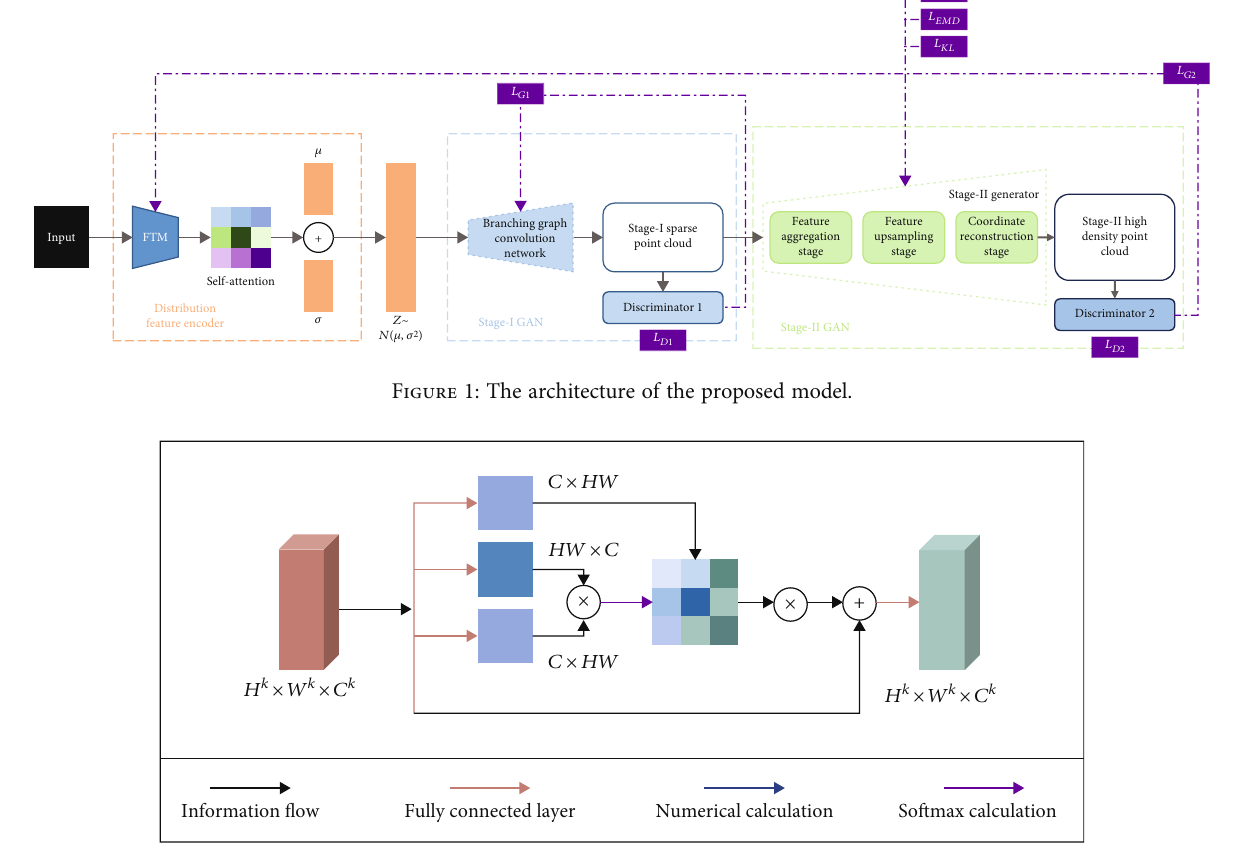
Figure 2: Traditional self-attention